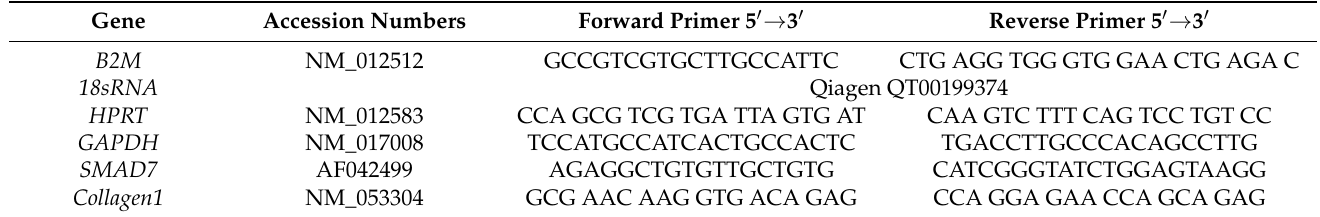
Table 1. Primer sequences used for real-time